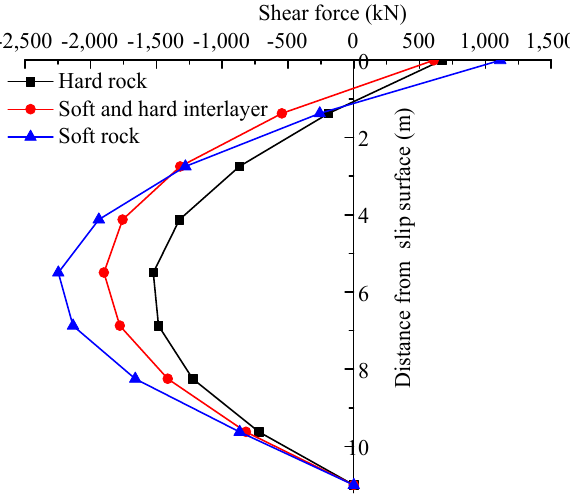
Figure 19. Shear force distributions along the embedded section of the stabilizing pile.